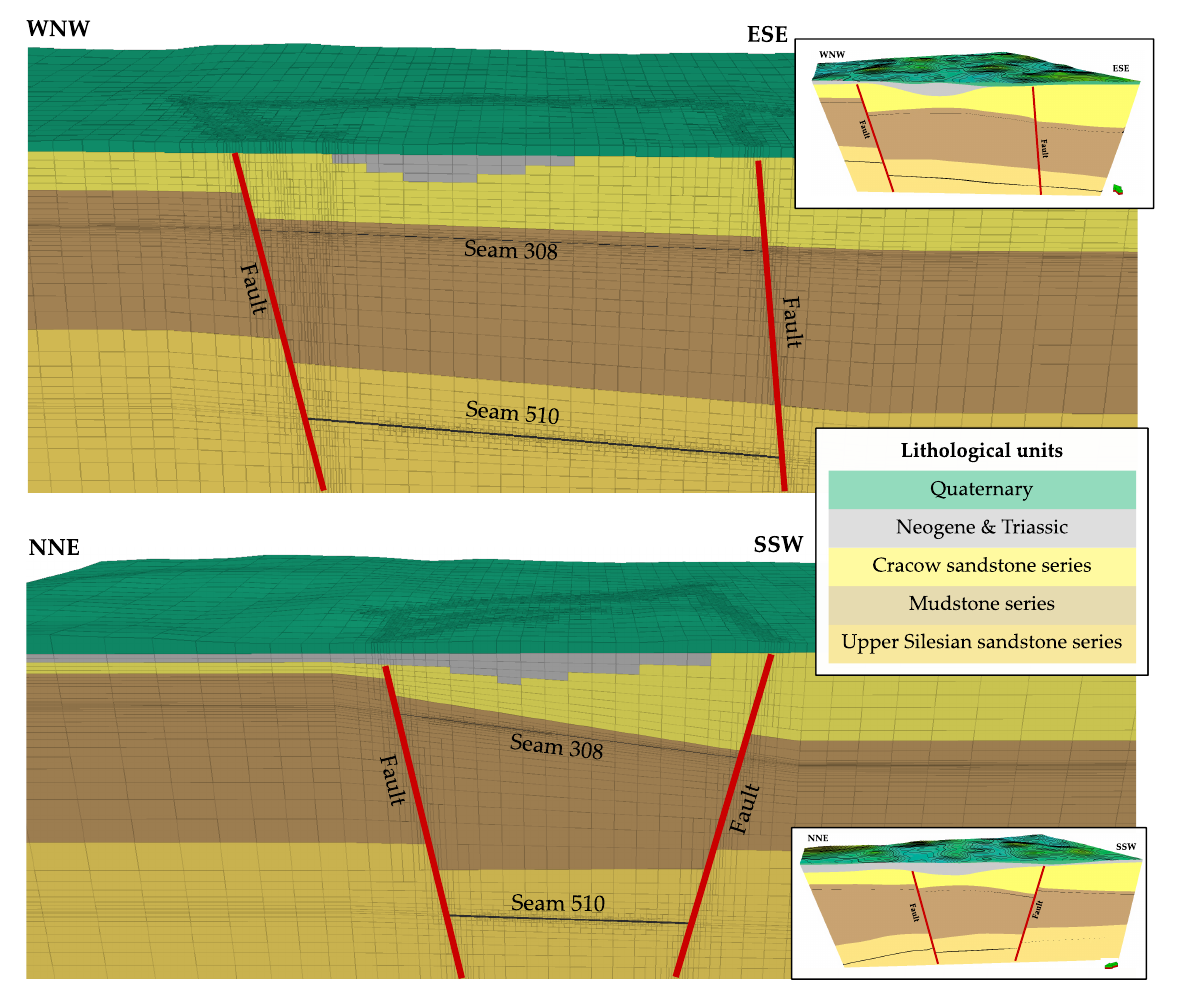
Figure 4. Comparisons of WNW-ESE ( above ) and NNE-SSW ( bottom ) cross sections of the numerical model with the respective cross-sections of the structural geologic model (illustrated cut-outs on the